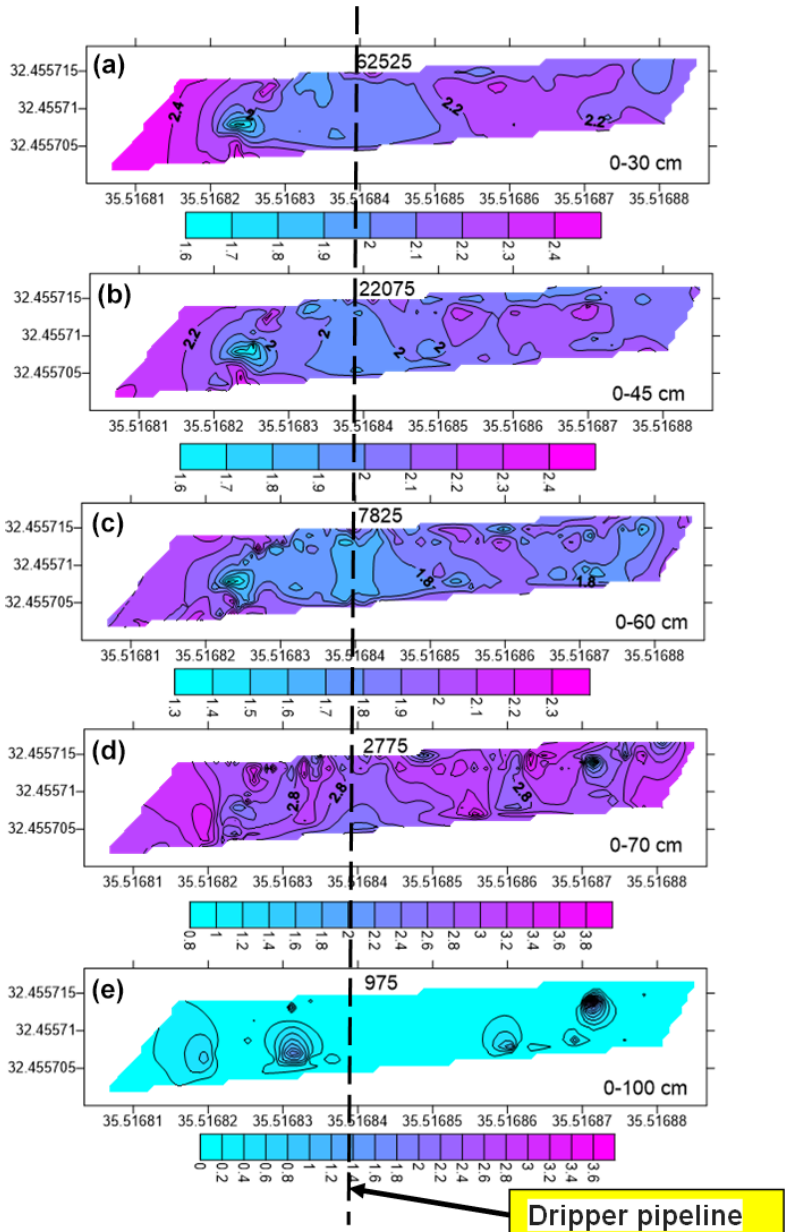
Figure 11. FDEM EC values for the different depths of the soil profile from the soil surface: (a) up to 30cm; (b) up to 45cm; (c) up to 60cm; (d) up to 70cm; (e) up to